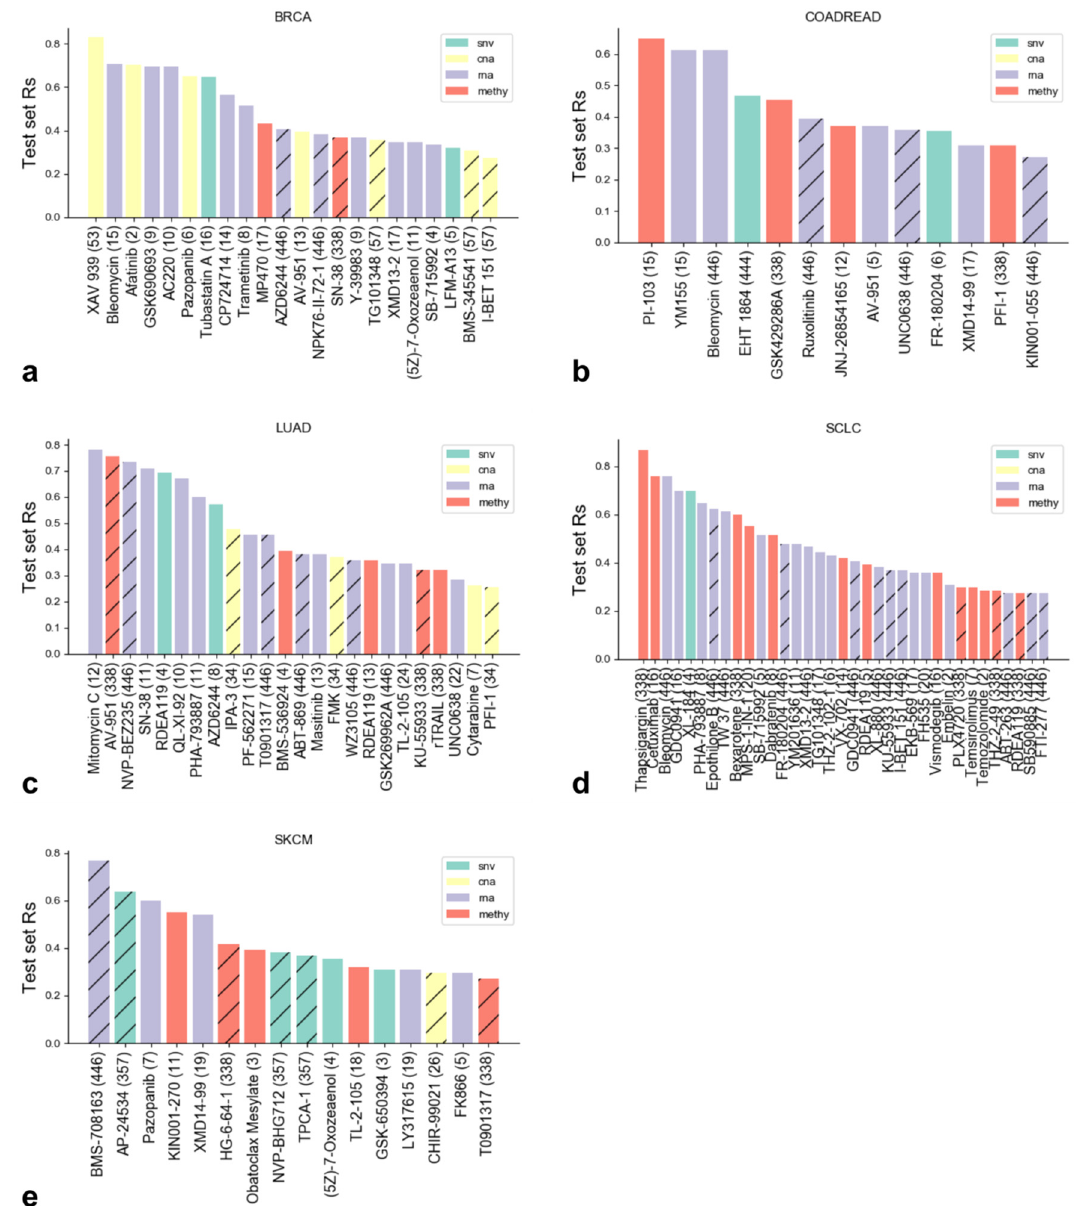
Figure 5. Test set Spearman’s correlation (Rs) between predicted and observed logIC50 of the best cases from each cancer type ( a : BRCA, b : COAD/READ, c : LUAD, d : SCLC, e : SKCM). The data type of the best case (i.e., highest Rs) is shown as color. If the bar is hatched, this indicates that using the XGB-all led to a predictive model where XGB-OMC did not (test set Rs < 0.25). Note that gene expression is the single most informative profile across the considered cancer types. The contributions the other omics data types can vary greatly based on the cancer type.